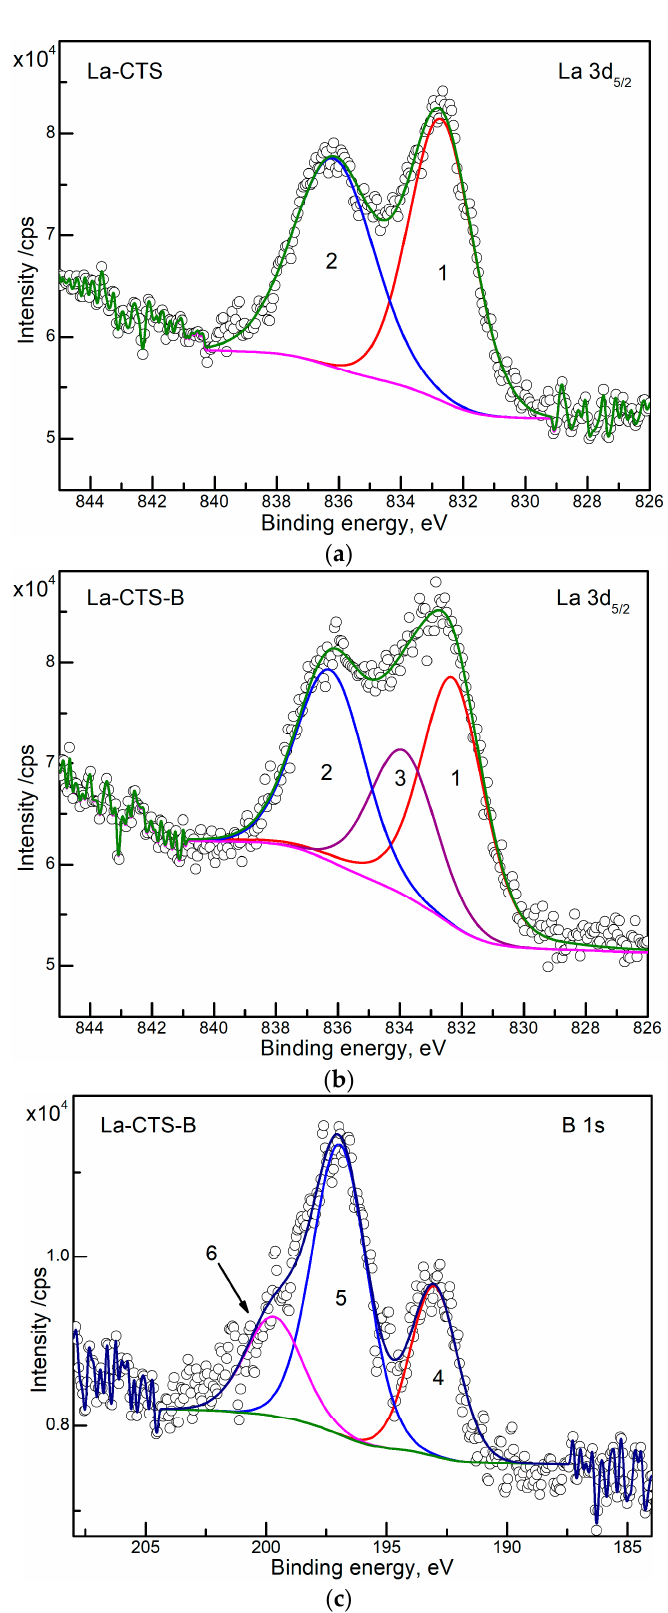
Figure 4. Hi-resolution XPS scans taken for representative XPS regions: ( a ) the La 3d 5/2 XPS region recorded for La-CTS sample; ( b ) the La 3d 5/2 XPS region recorded for La-CTS-B sample; ( c ) the B 1s XPS region recorded for La-CTS-B sample. Component assignment (given in Arabic numbers): (1) La-NH 2 ; (2) La-OH/La-OH(H 2 O); (3) La-O-B; (4) La-O-B; (5) B-OH (6) is the plasmon energy loss feature.